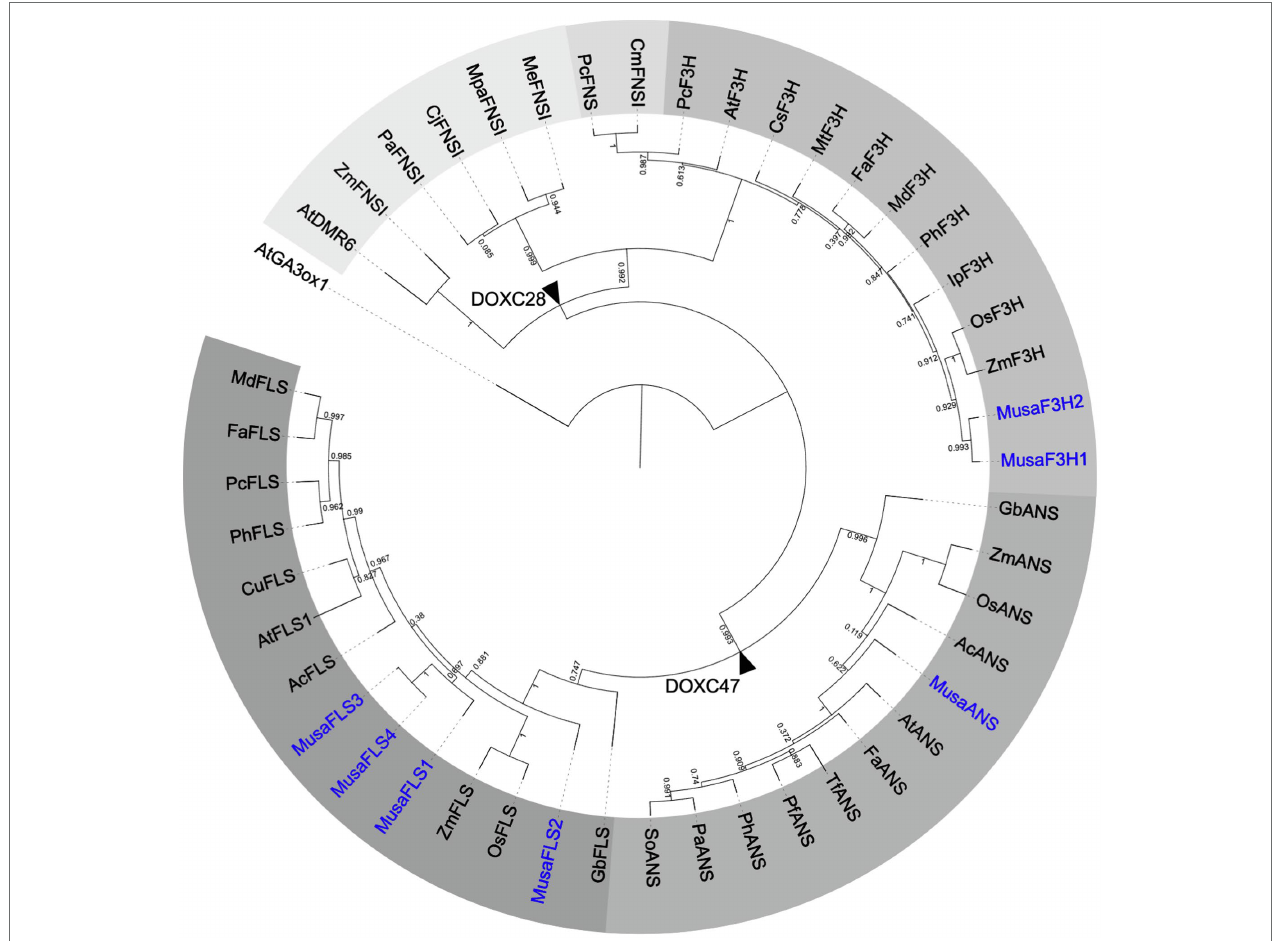
FIGURE 2 | Rooted approximately maximum-likelihood (ML) phylogenetic tree of 2-ODDs involved in flavonoid biosynthesis. ODDs from banana are given in blue, 39 enzymes with proven F3H, FNSI, FLS or ANS activity were included. Different grey scales indicate F3H, FLS, ANS and two evolutionary FNSI clades. At GA3ox1 (gibberellin 3 beta-hydroxylase1) was used as an outgroup. Branch points to DOXC28 and DOXC47 classes are marked with black